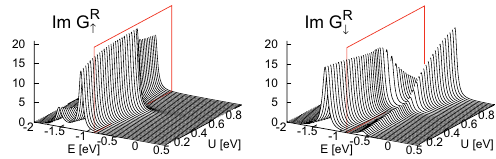
Fig. 4. The asymptotic spectral density of the island level for both spin oprientations as a function of energy and the Hubbard U.